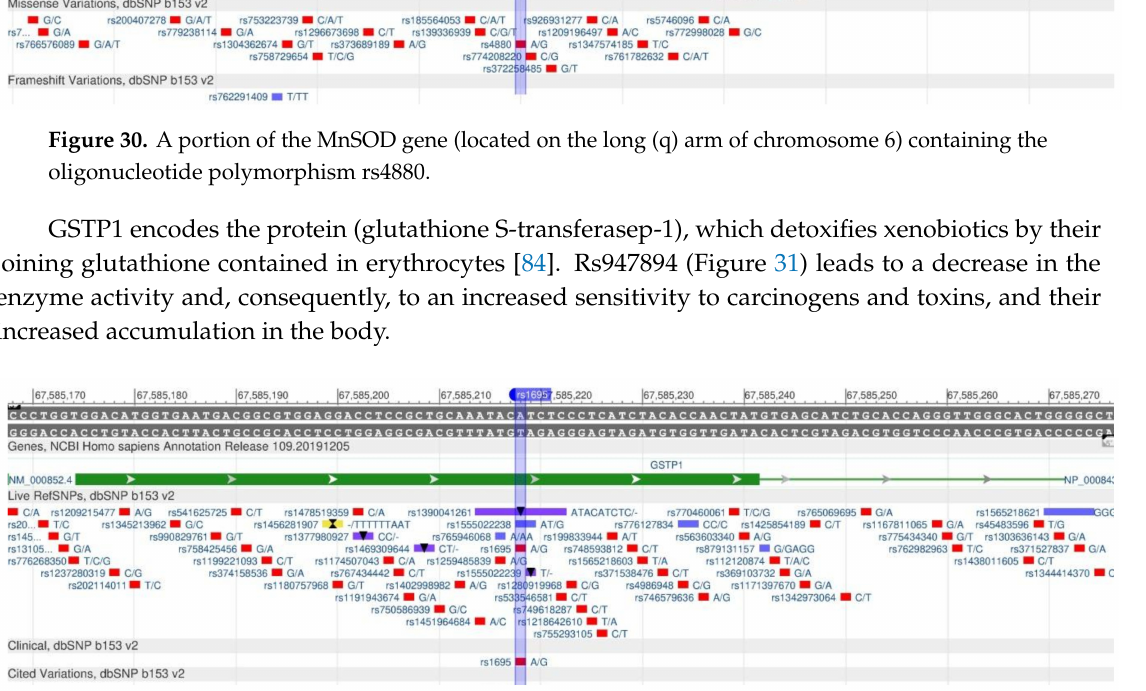
Figure 31. The GSTP1 gene region (located on the long (q) arm of chromosome 11) containing the oligonucleotide polymorphism